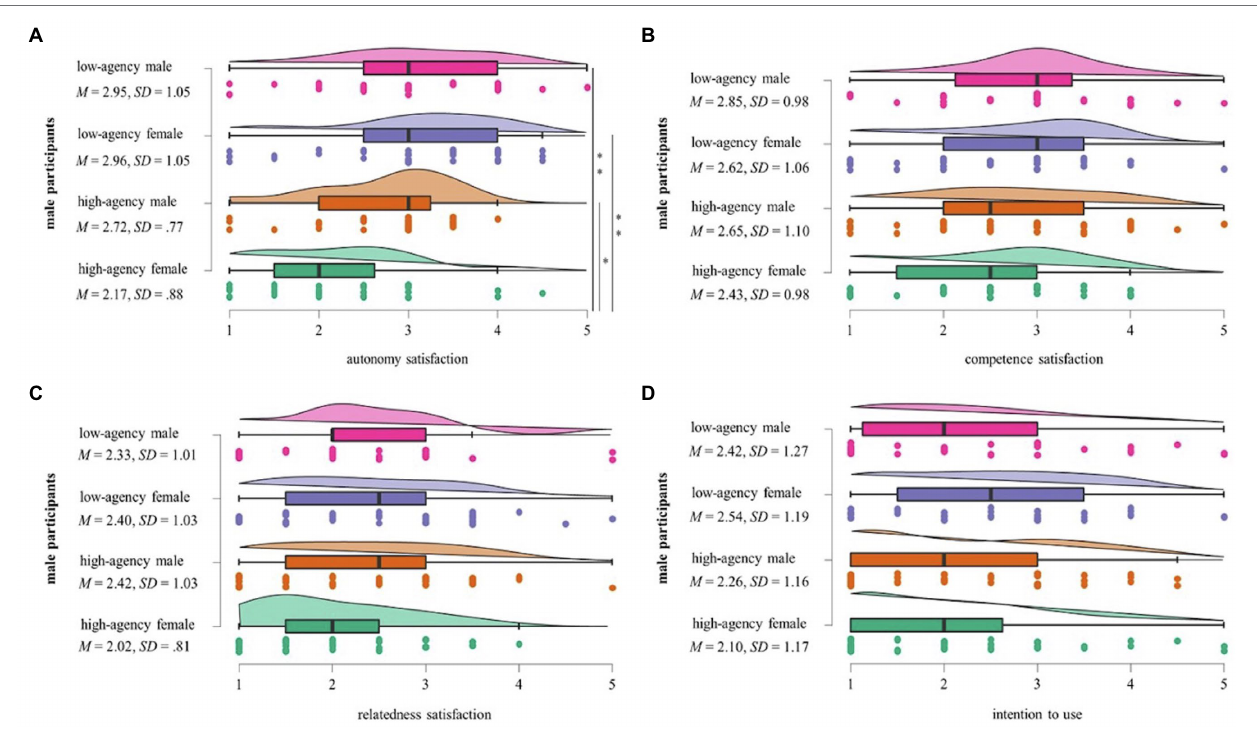
FIGURE 2 | Male participants’ mean scores for the four finance coach type conditions. Significant interactions are demonstrated with a line on the right hand side. One asterisk * demonstrates a significance level of p < 0.05 and two asterisks ** demonstrate a significance level of p <